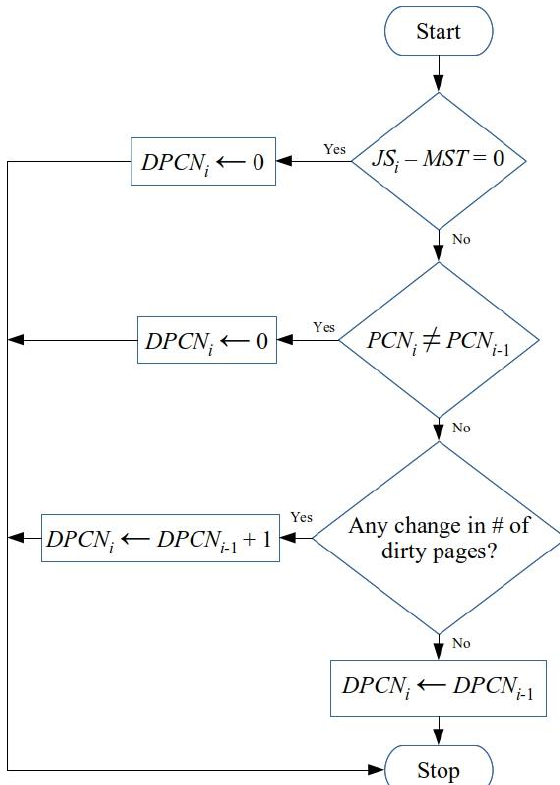
Figure 4. Supply appropriate values for the DPCN field.